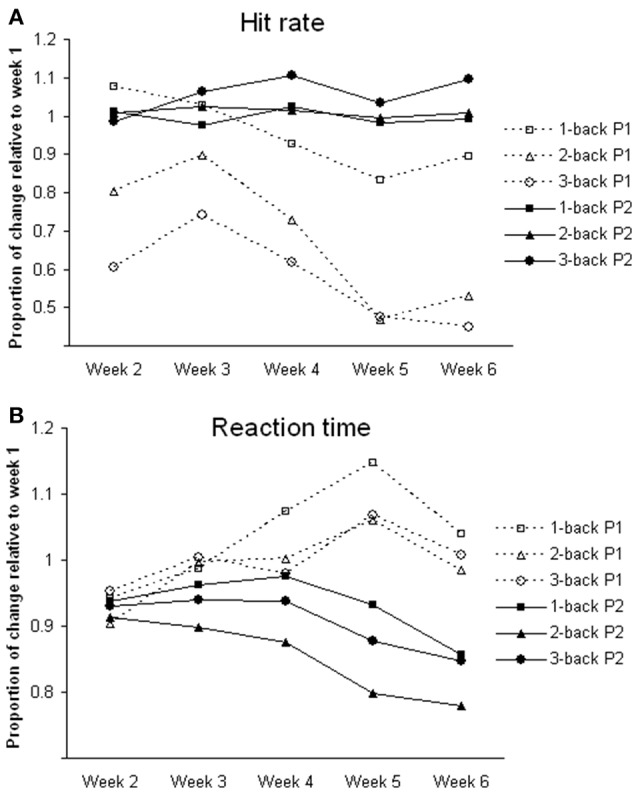
Changes of task performance during training. All values are relative to week 1. (A) Hit rate; calculated by dividing hit rate (%) in each week by that in week 1; greater the value better the performance. (B) Reaction time; calculated by dividing reaction time (ms) in each week by that in week 1; greater the value slower the reaction time. P1, participant 1; P2, participant 2.